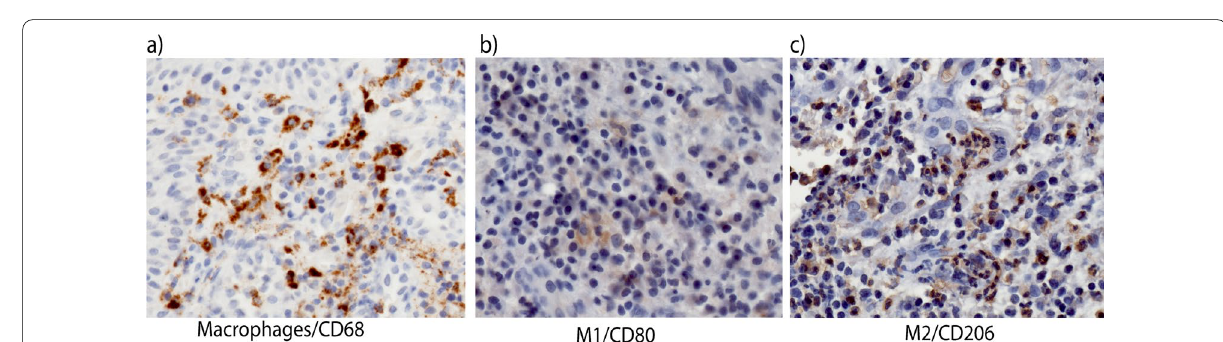
Fig. 2 Histological sections depicting the antigen‑ reactivity for a macrophages (CD68), b M1 (CD80) and c M2 (CD206)